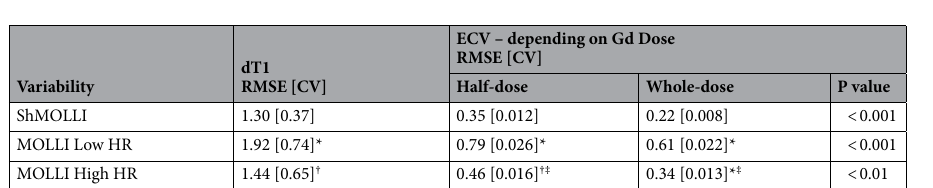
Table 3. Measures of intra-individual variability across different T1-mapping variants measured by RMSE[CV]. * = P < 0.05 compared with ShMOLLI. † = P > 0.05 compared with ShMOLLI. ‡ = P < 0.05 compared with MOLLI Low HR. RMSE = Root Mean Square Error and refers to the standard deviation of the residuals. CV = Coefficient of Variance (RMSE/mean).